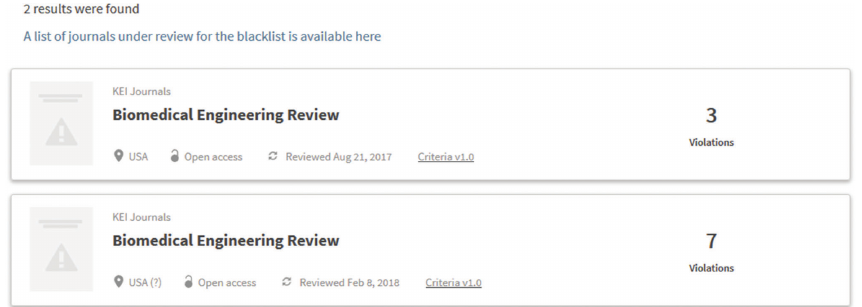
Fig. 6: Two different entries for identical journal Biomedical Engineering Review as they appear on Cabell’s blacklist. Screenshot captured on September 8,